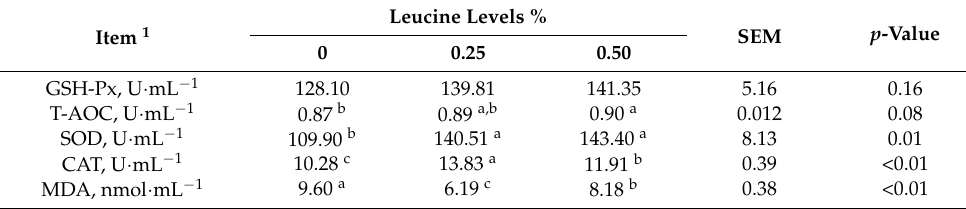
Table 8. Effects of different levels of leucine on liver antioxidant enzyme activities of finishing pigs.